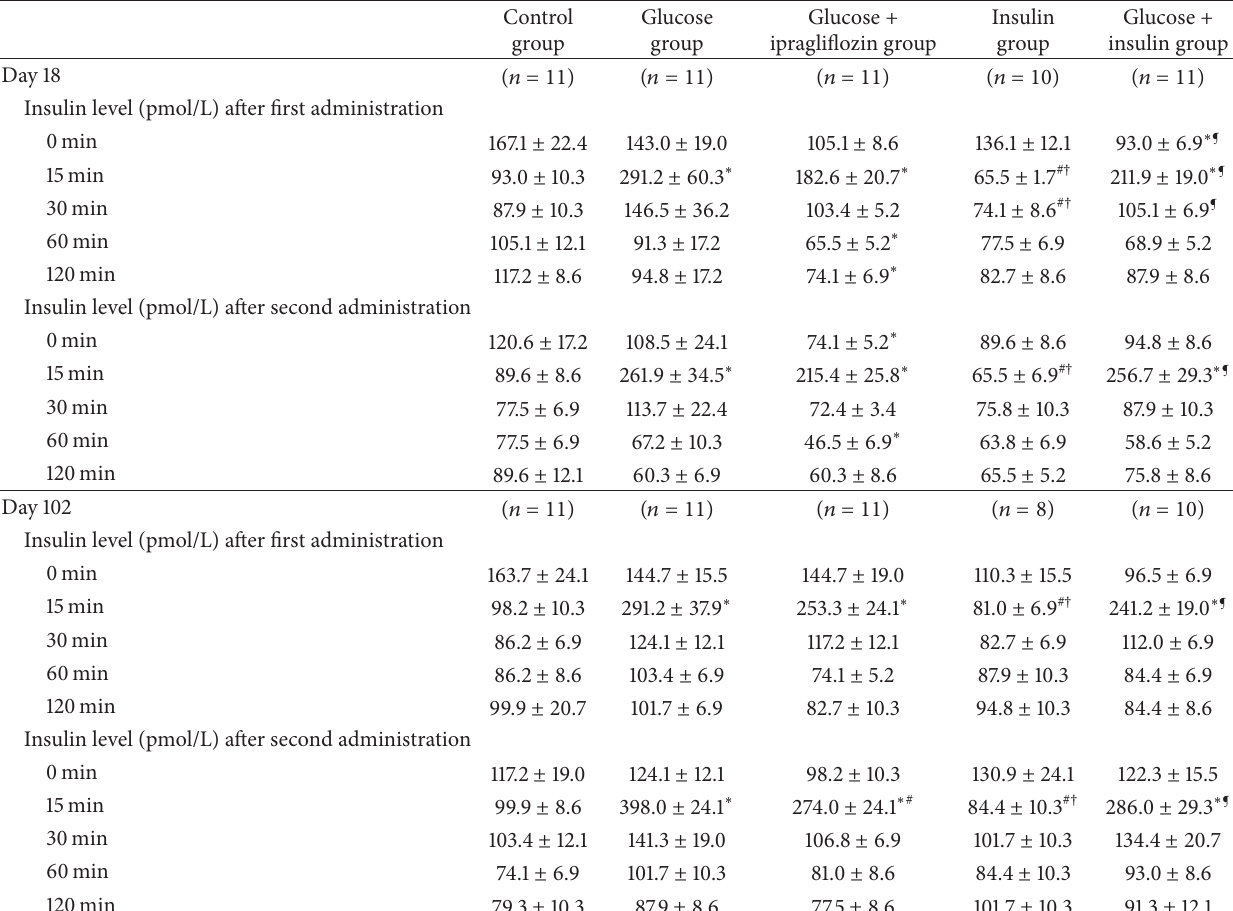
Table 3: Daily plasma insulin profile of each group. Control group